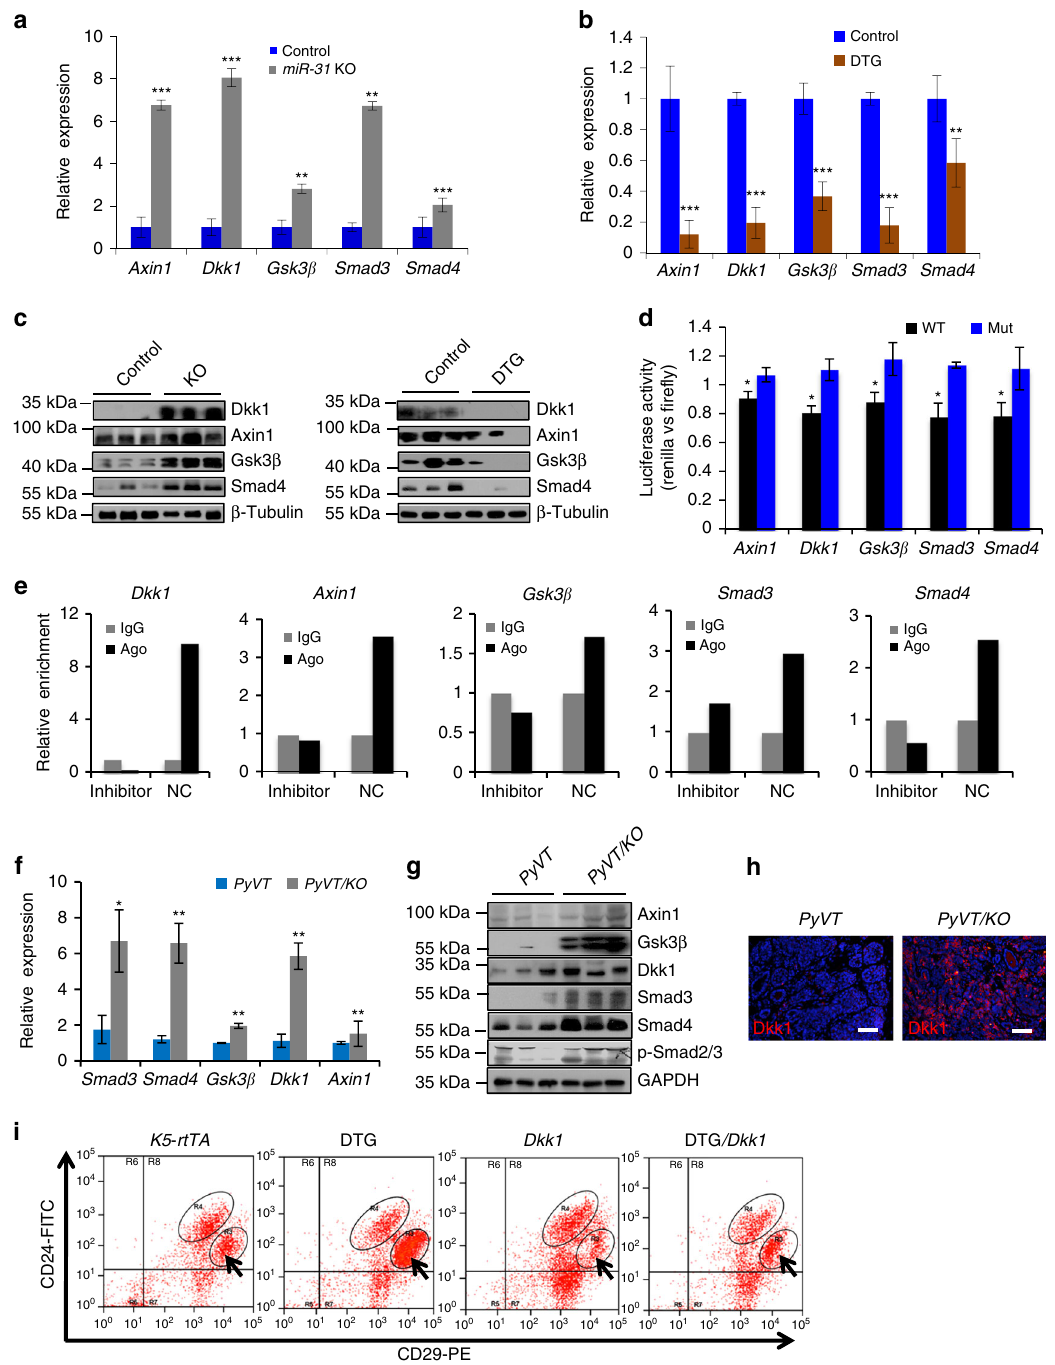
Fig. 8 Identi fi cation of miR-31 direct targets. a , b qRT-PCR analysis for Axin1 , Dkk1 , Gsk3 β , Smad3 and Smad4 in Control ( n = 3) and miR-31 KO ( n = 3) a , as well as Control ( n = 3) and DTG ( n = 3) b mammary epithelium. c Western blotting for Dkk1, Axin1, Gsk3 β and Smad4 in Control ( n = 3) and miR-31 KO ( n = 3), as well as Control ( n = 3) and DTG ( n = 3) mammary epithelium. β -Tubulin was used as a loading control. d Ratio of luciferase activity of miR-31 mimics vs. scrambled RNA in wild type (WT) and mutant (Mut) 3 ’ -UTR constructs based on 3 independent experiments. e RNA crosslinking, immunoprecipitation, and qRT-PCR (CLIP-PCR) assay for Dkk1 , Axin1 , Gsk3 β , Smad3 and Smad4 upon Ago2 antibody immunoprecipitates in response to miR-31 inhibitor and scramble RNA (NC). IgG was used as a negative control. f qRT-PCR analysis for Smad3 , Smad4 , Axin1 , Dkk1 and Gsk3 β in PyVT ( n = 3) and PyVT/KO ( n = 3) tumors. g Western blotting for Dkk1, Axin1, Gsk3 β , Smad4 and p-Smad2/3 in PyVT ( n = 3) and PyVT/KO ( n = 3) tumors at 12 weeks of age. β -Tubulin was used as a loading control. h Immuno fl uoresence for Dkk1 in PyVT ( n = 3) and PyVT/KO ( n = 3) tumors at 12 weeks of age. Scale bar, 50 μ m. i Flow cytometry pro fi les of CD24-FITC and CD29-PE in cell suspensions of mammary epithelium from K5-rtTA ( n = 3), DTG ( n = 3), Dkk1 ( n = 3) and DTG/ Dkk1 ( n = 3) mice. Arrows indicated CD24 + CD29 high cell population. n = 3 biological replicates. Data represented as mean ± S.D. n = 3. Two tailed unpaired t -test for a , b , d , f (* P < 0.05; ** P < 0.01; *** P < 0.001)